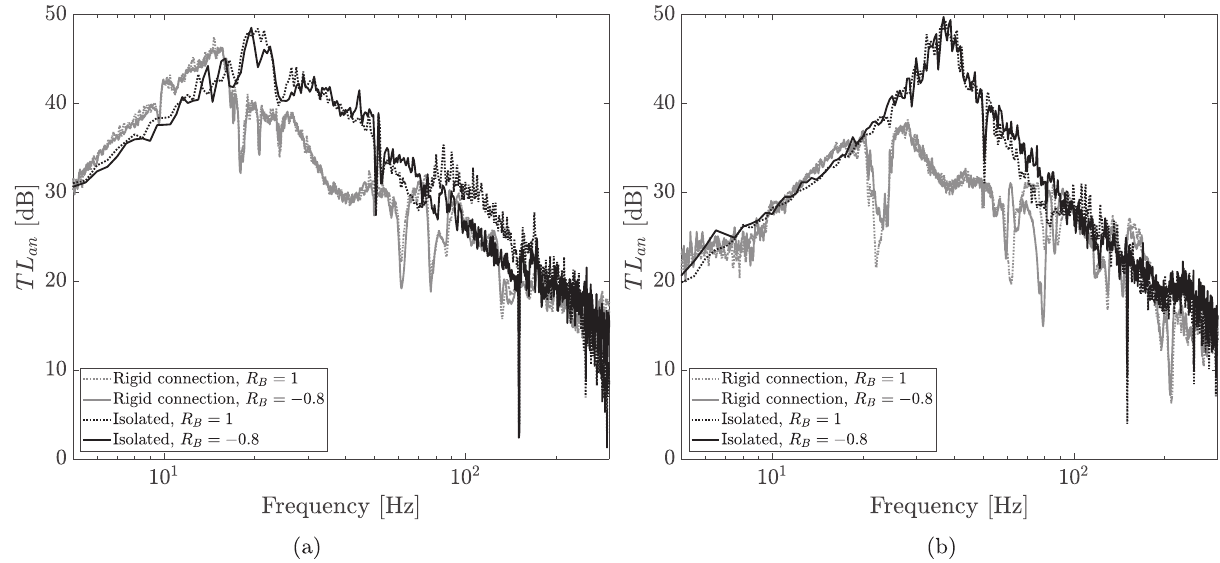
Figure 5. Comparison between measured TL an of a dynamically isolated test setup and a rigidly connected test setup to the sound source (ori fi ce). The TL an was calculated using the multi-microphone method for fl exible plate resonator with t plate = 1 mm (a) and 2 mm